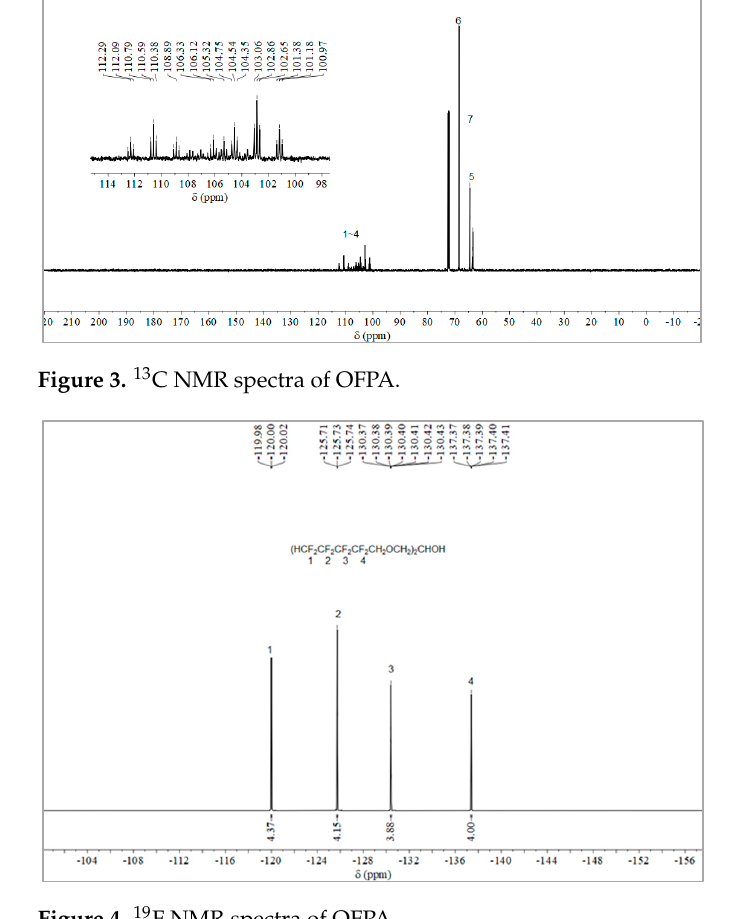
Figure 4. 19 F NMR spectra of OFPA.